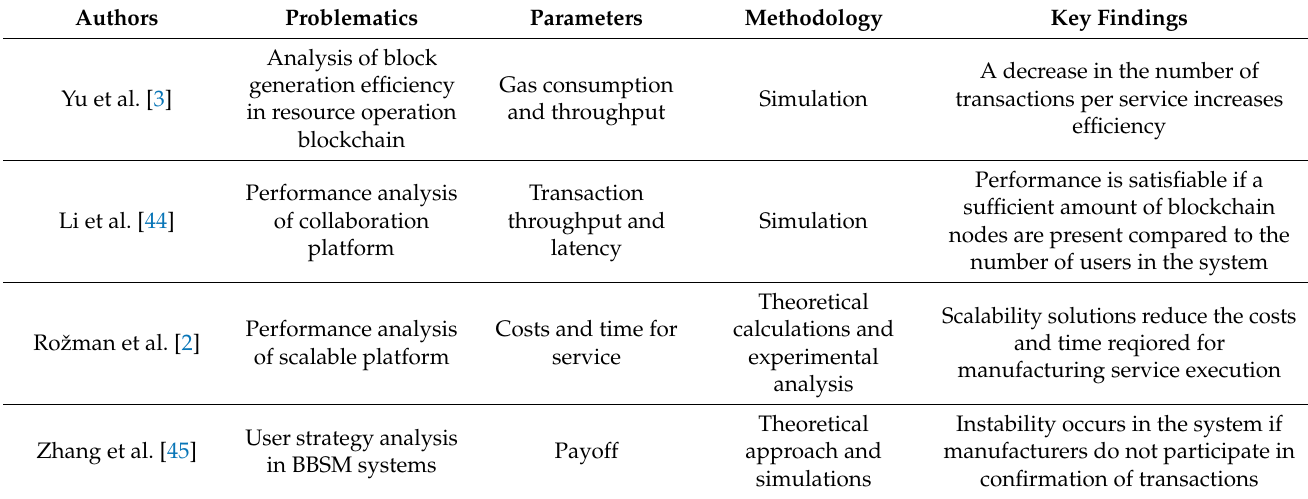
Table 2. Existing studies on blockchain-based shared